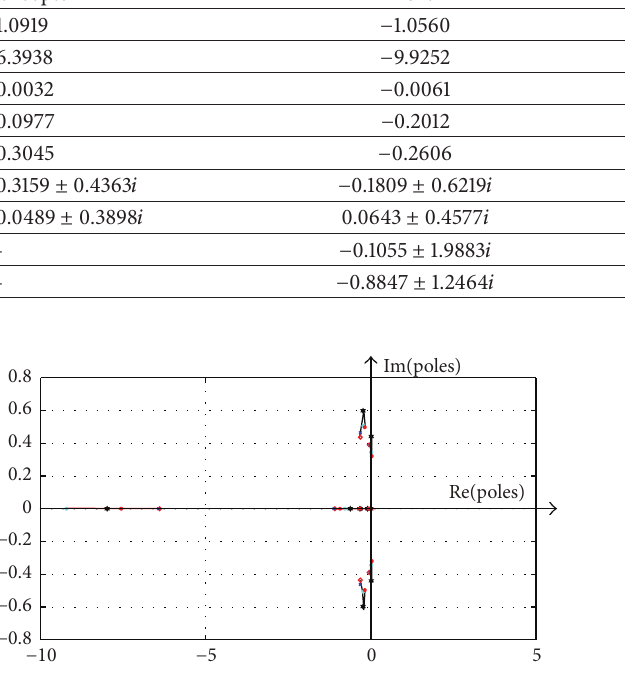
Figure 5: System root-locus showing pole locus for constant load weight (1000 lb) as slung length is increased.